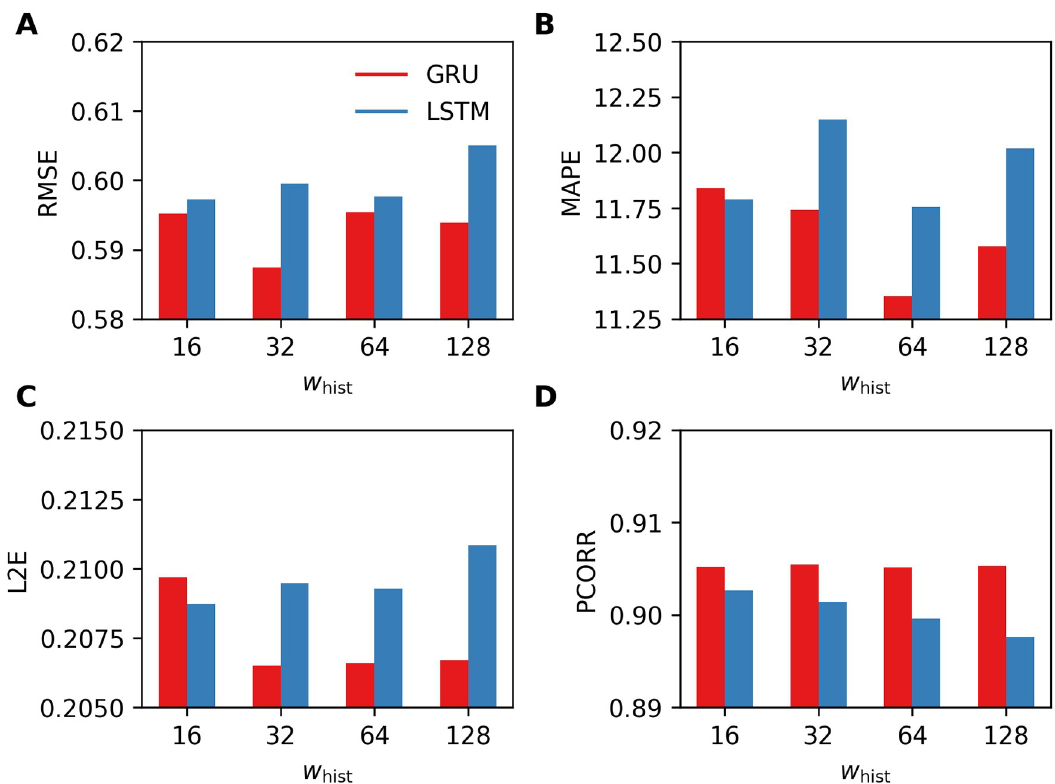
Fig 6. Four performance metrics for one-week-ahead predictions obtained by using RNN-LSTM and RNN-GRU. A. RMSE, B. MAPE, C. L2E, and D. PCORR. Smaller values are preferable for RMSE, MAPE, L2E, and larger values are preferable for PCORR.